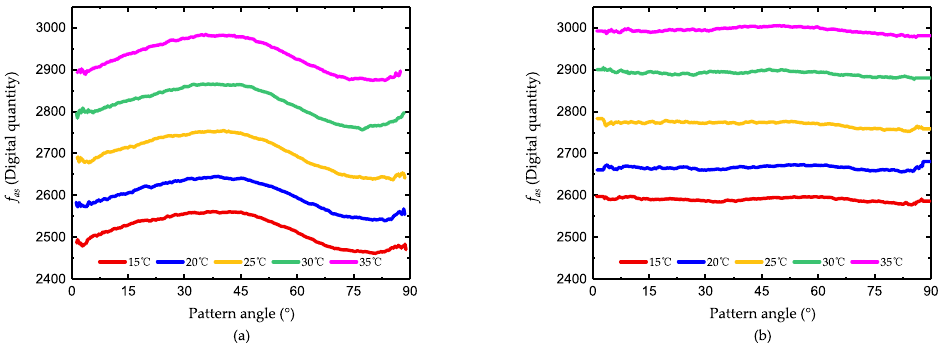
Figure 10. The temperature robustness experiment of damping tuning ( a ) before damping tuning and ( b ) after damping